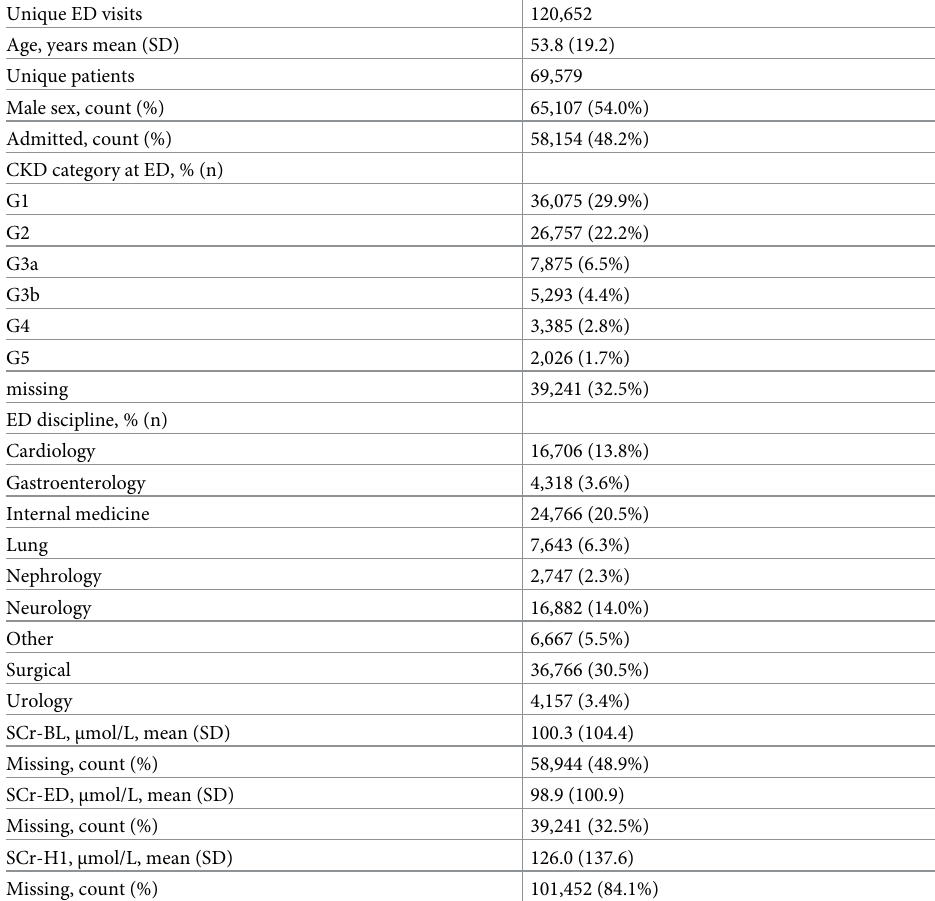
Table 1. Characteristics of all emergency department (ED)